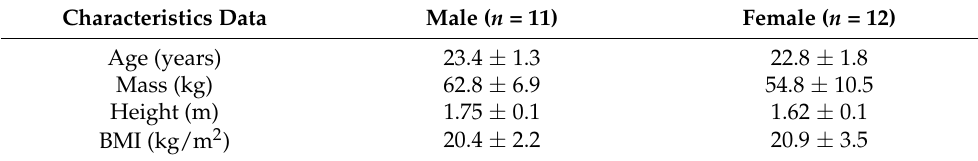
Table 1. Characteristics of the